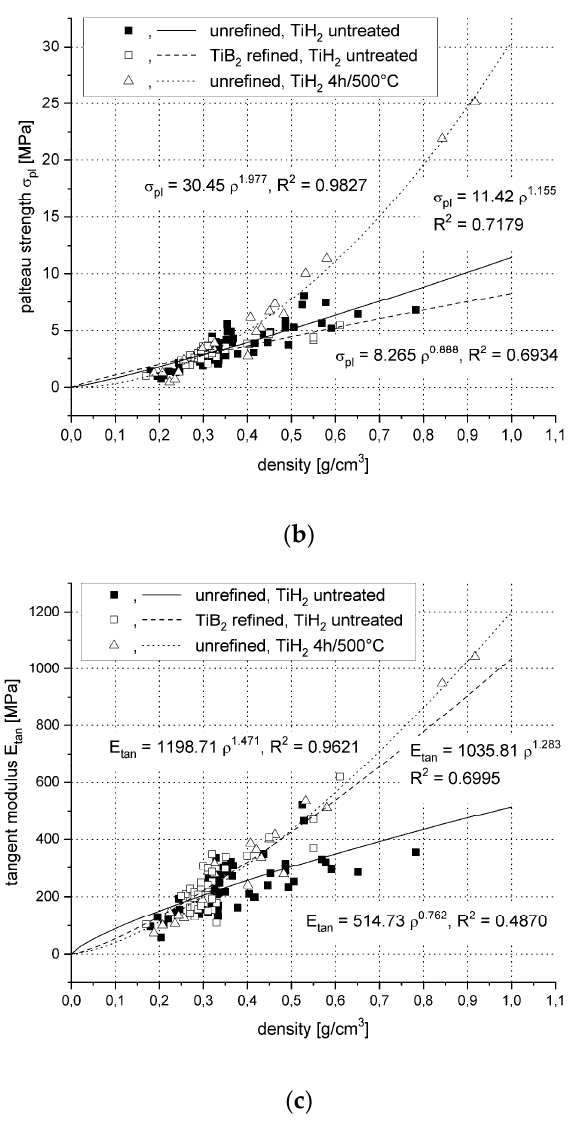
Figure 13. Compression test results: ultimate compressive strength ( a ), plateau strength ( b ) and tangent modulus ( c ) versus density. Table 5. Compression test results, comparison of fit curve parameters for density dependence of plateau and ultimate strength as well as tangent modulus for different sample series (standard series with TiH 2 as received and thermally treated, TiB 2 grain refined with TiH 2 as received—all series produced using forced convection cooling with air).